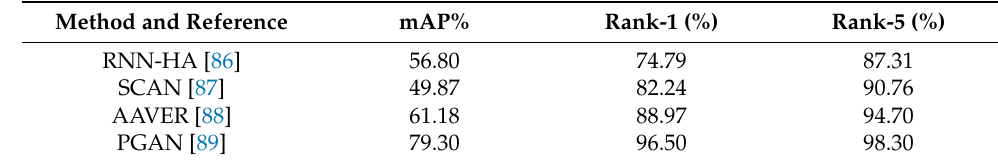
Table 2. Comparison of different attention mechanism-based